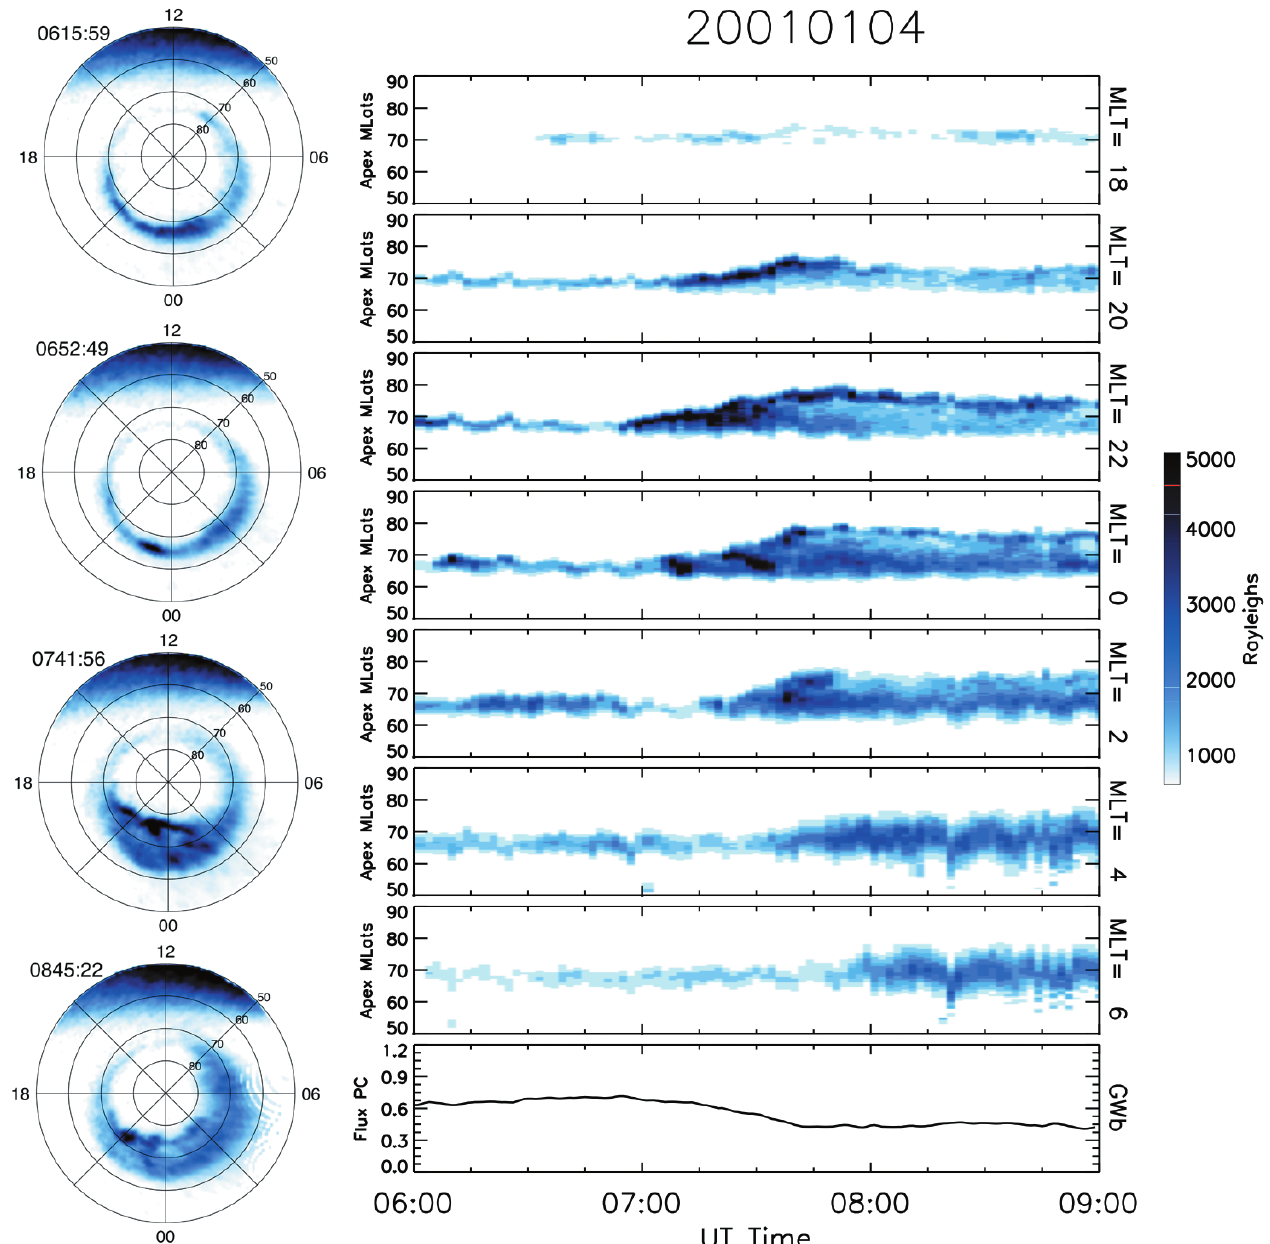
Fig. 3. A stack plot of keograms for the isolated substorm on 4 January 2001. The polar cap open magnetic flux is plotted at the bottom. For reference, there are images of the aurora through out the period shown. The color indicates intensity of the aurora in